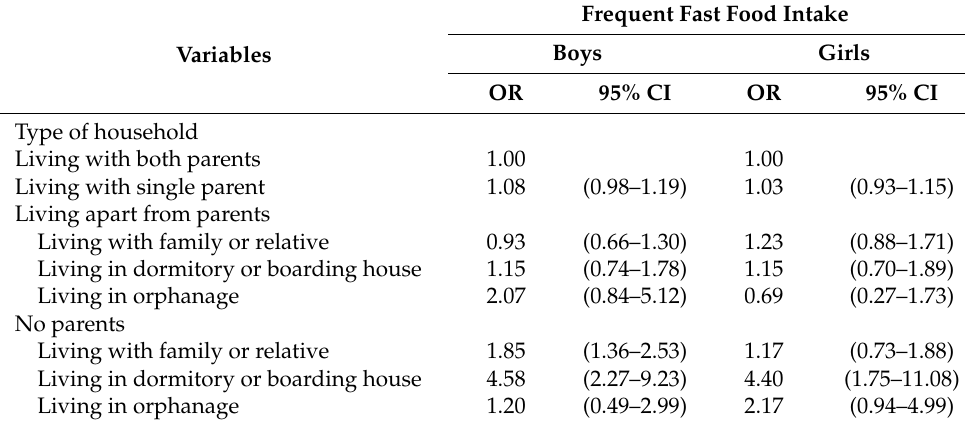
Table 4. Results of factors associated with fast food